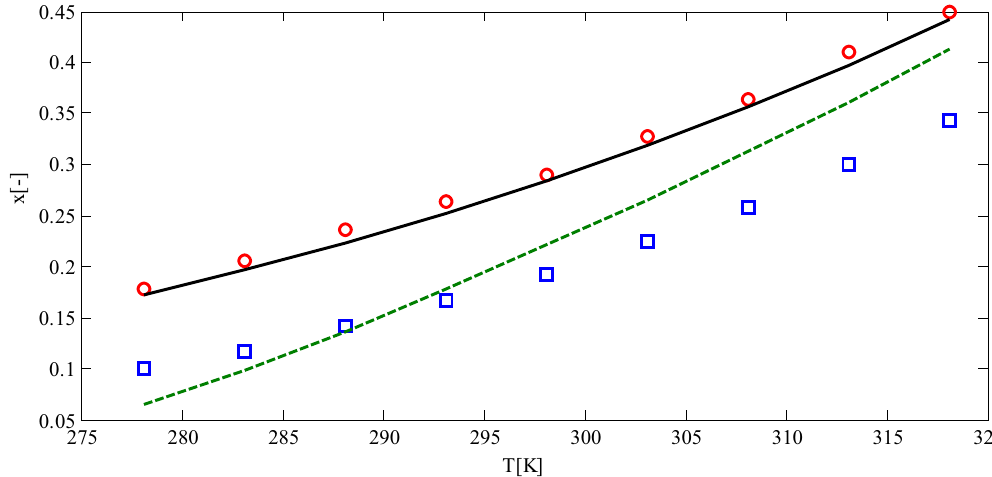
Figure 6. The predictive PC-SAFT EOS solubilities for 4-methylphthalic anhydride in methyl acetate (solid line) and acetonitrile (dashed line) in comparison to experimental data for solubility of 4-methylphthalic anhydride in methyl acetate (circle) and acetonitrile (square) 39 .